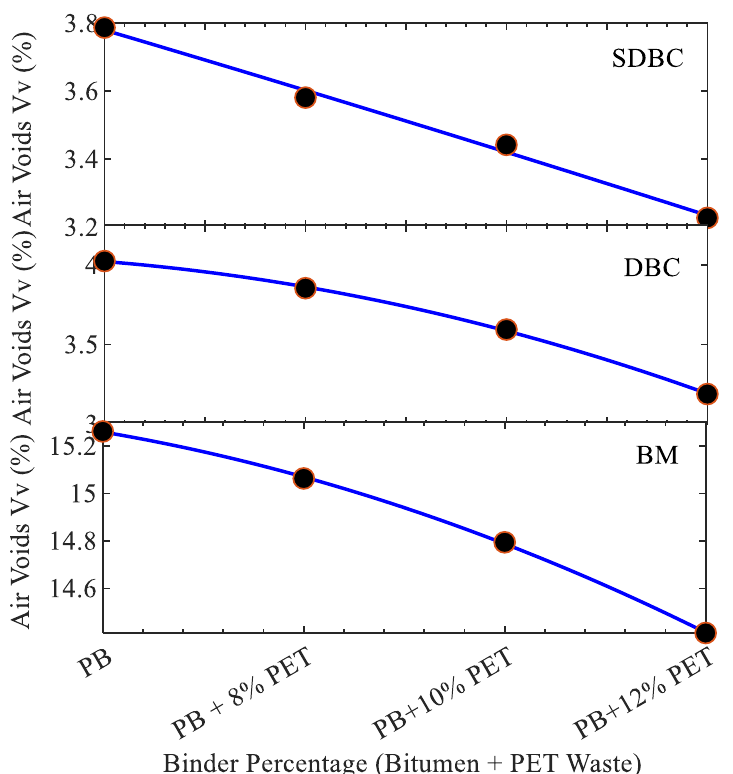
Fig. 27 Relations between air voids and binder content for modified SDBC, DBM, and